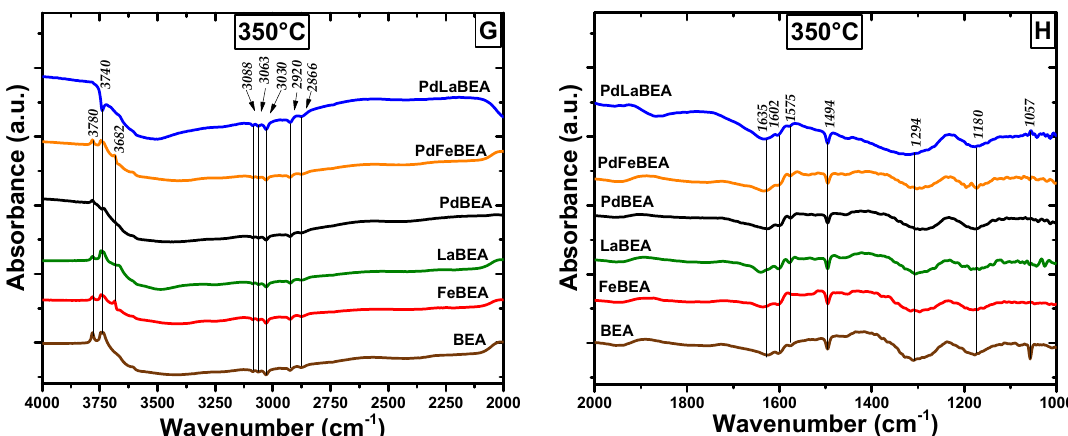
Figure 11. In situ DRIFTS spectra recorded in Ar after stepwise increasing the temperature from 80–350 ◦ C after exposing the samples for toluene at 80 ◦ C. Panels A, C, E, and G show the wavenumber region 4000–2000 cm − 1 . Panels B, D, F, and H show the wavenumber region 2000–1000 cm − 1 .